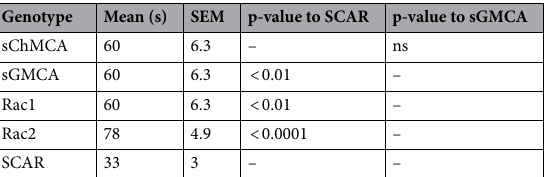
Table 1. Time when each reporter is first recruited to the wound periphery. Statistical tests were performed using Kruskal–Wallis test.